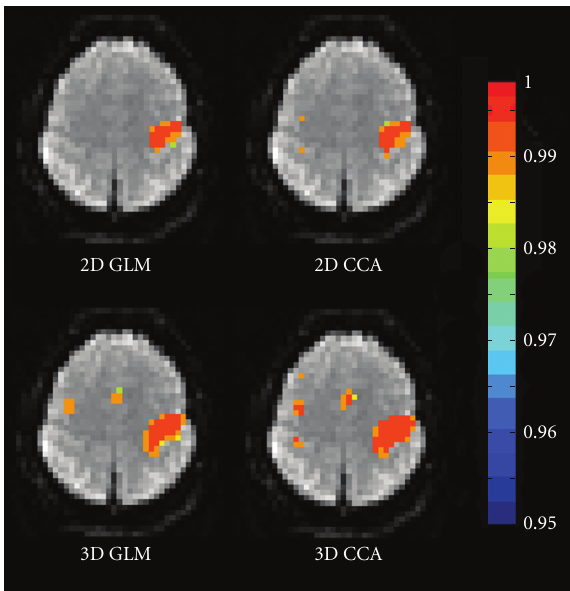
Figure 8: Top : A comparison between corrected P values from 2D GLM (left) and 2D CCA (right), calculated from a random permutation test with 10000 permutations. The activity maps are thresholded at the same significance level (corrected P = 0.05). The GLM used one isotropic 8 mm FWHM 2D Gaussian smoothing kernel while CCA used one isotropic 2D Gaussian kernel and 3 anisotropic 2D Gaussian kernels, designed such that the largest possible filter that CCA can create has an FWHM of 8mm. The neurological display convention is used (left is left), 1 − p is shown instead of p . Note that CCA detects active voxels in the left motor cortex and in the left somatosensory cortex that are not detected by the GLM. Bottom : A comparison between corrected P values from 3D GLM (left) and 3D CCA (right), calculated from a random permutation test with 10000 permutations. The activity maps are thresholded at the same significance level (corrected P = 0.05). The GLM used one isotropic 8 mm FWHM 3D Gaussian smoothing kernel while CCA used one isotropic 3D Gaussian kernel and its derivative, designed such that the largest possible filter that CCA can create has a FWHM of 8mm. The neurological display convention is used (left is left), 1 − p is shown instead of p . Note that CCA detects active voxels in the left somatosensory cortex that are not detected by the